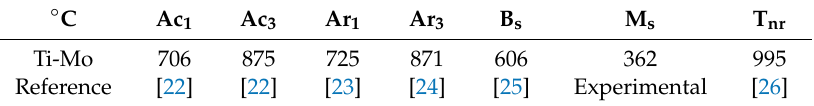
Table 2. Critical Transformation Temperature Estimates for the Experimental Alloy.